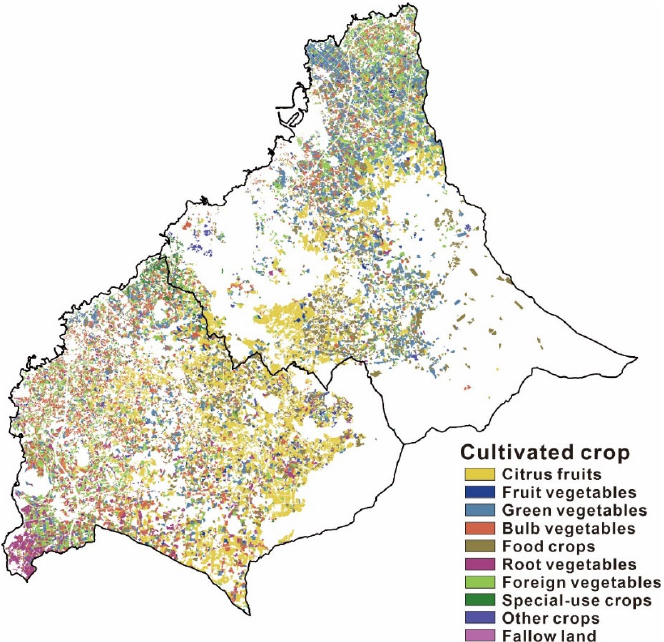
Figure 3. Spatial map of cultivated crops during the second half of 2018. Table 2. Cultivated crops and area in the Hankyung and Hanrim study regions.